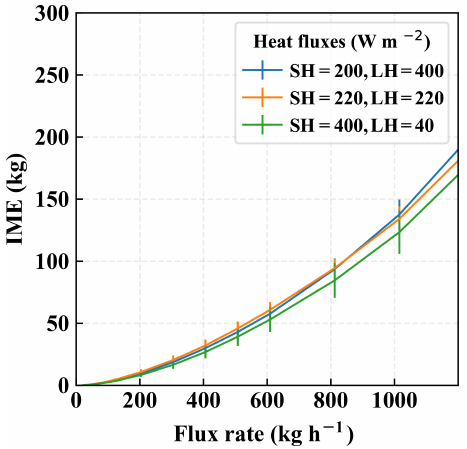
Figure 13. Comparison between the predicted and the actual total flux of 30 plumes from 3000 bootstrap rounds.